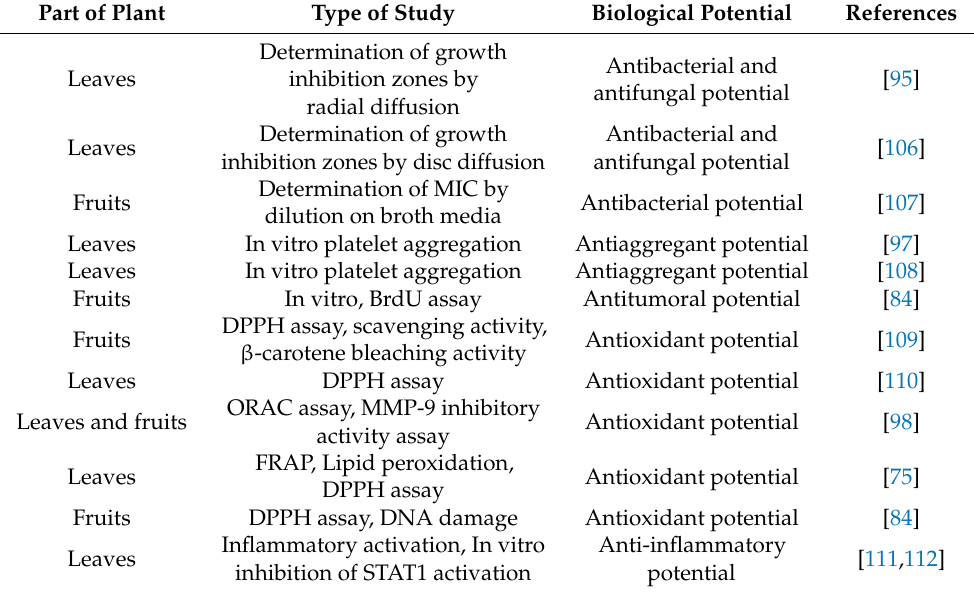
Table 2. Biological potential of Arbutus unedo L. fruits and leaves. Part of Plant Type of